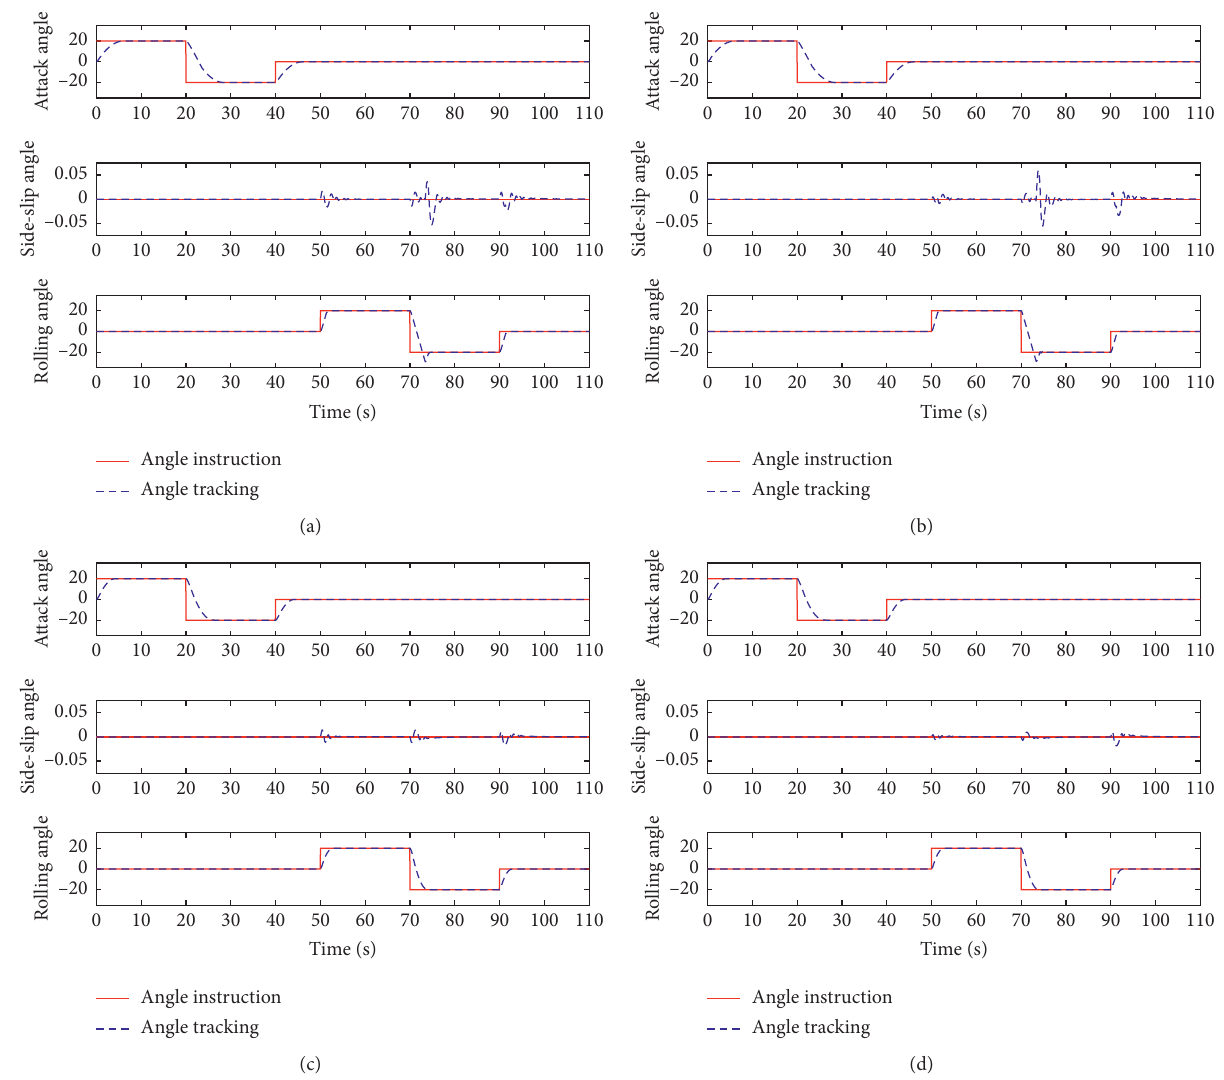
Figure 5: Attitude angle-tracking curves in the four cases: (a) attitude angle-tracking curve with baseline without uncertainties, (b) attitude angle-tracking curve with baseline under uncertainties, (c) attitude angle-tracking curve with optimal parameters without uncertainties, and (d) attitude angle-tracking curve with optimal parameters under